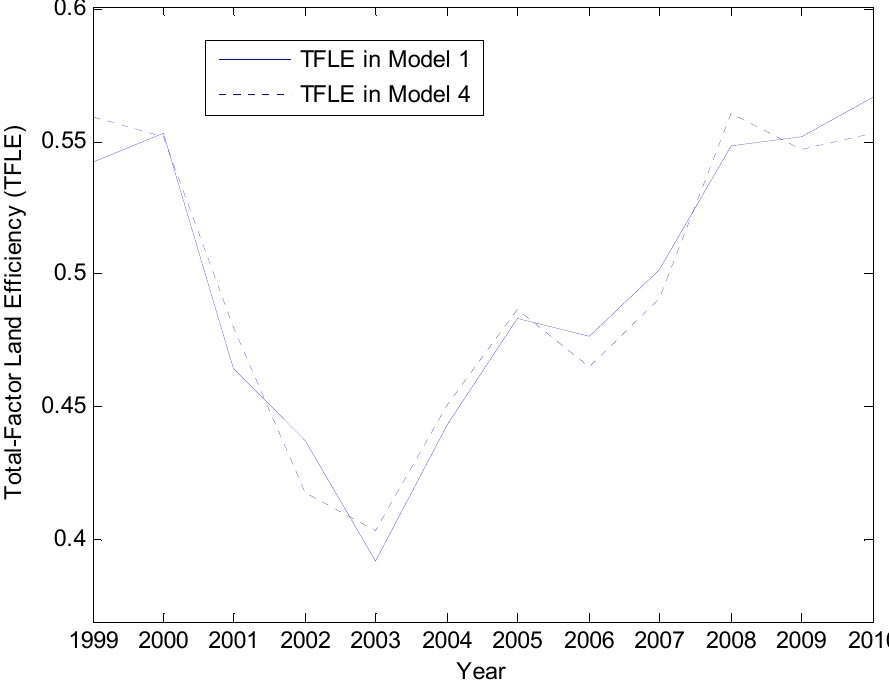
Figure 7. TFLE estimated by Model 1 (with energy factor) and Model 4 (without energy